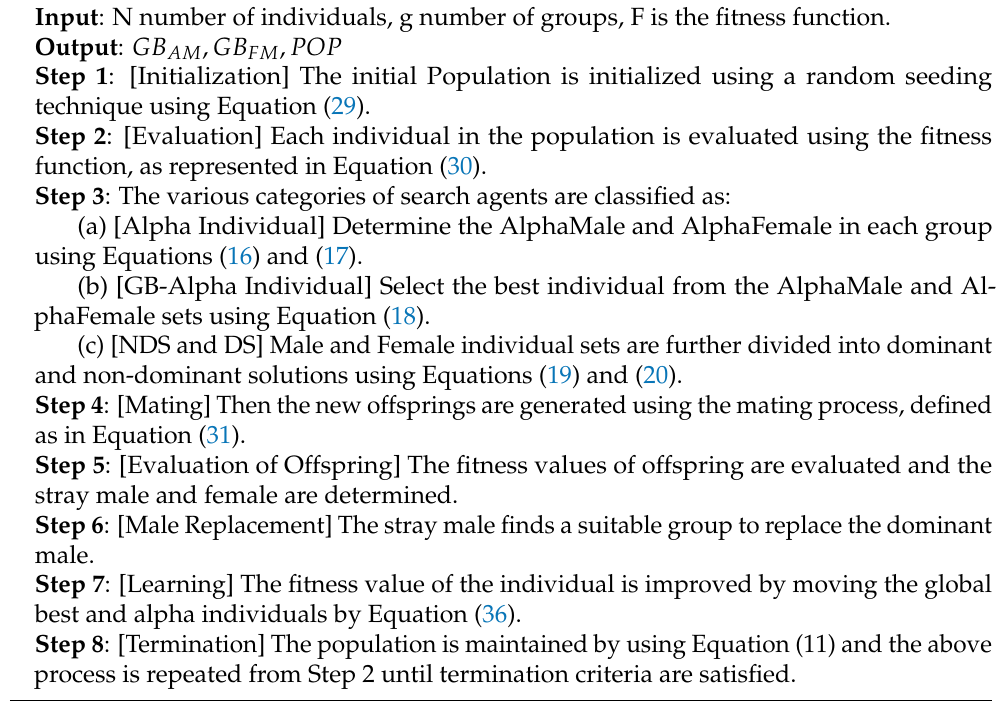
Algorithm 1 JMAC: Java Macaque Algorithm for Continuous Optimization